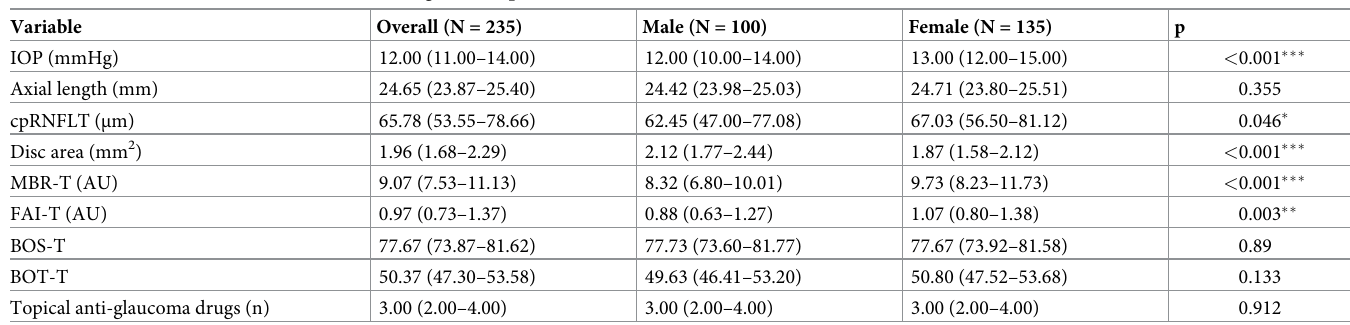
Table 2. Ocular characteristics of normal-tension glaucoma